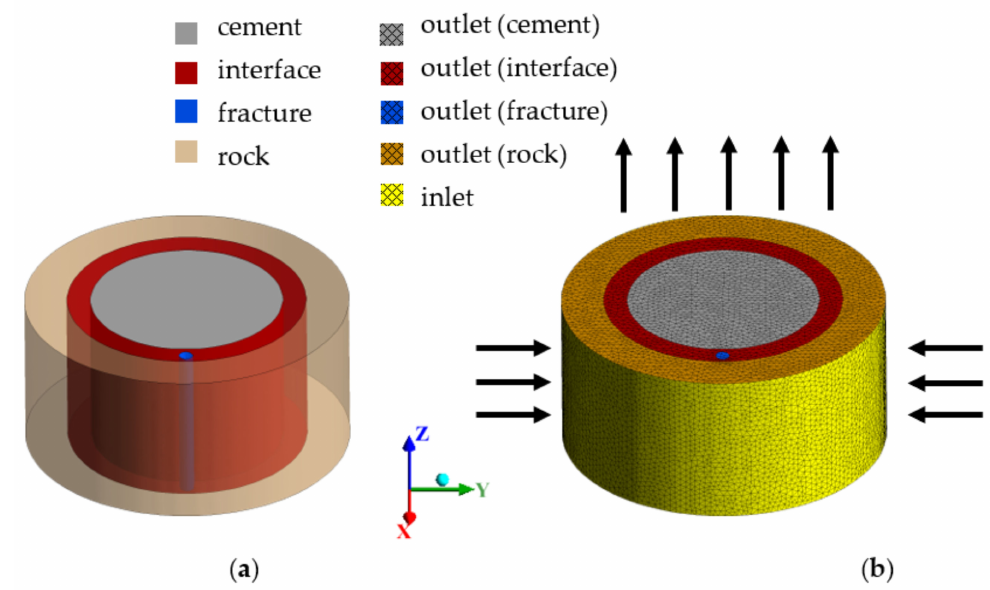
Figure 9. Physical geometry and boundary conditions for a 3D model with a circular simulated microchannel with a cross-sectional area of 64 pixel 2 (0.2273 mm 2 ). ( a ) physical geometry, ( b ) bound- ary conditions.